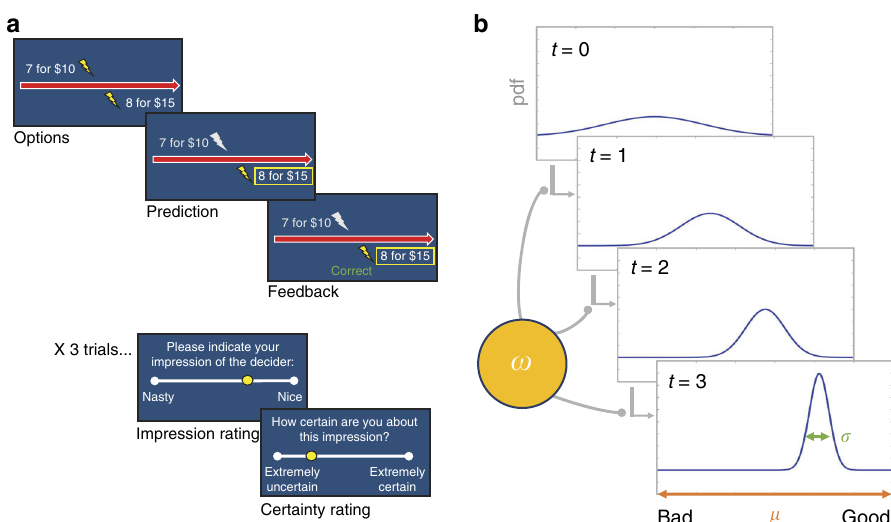
Fig. 1 Learning task and model. a Representation of the task schematic, created by the authors. Participants predicted sequences of choices for two agents (Decider A and Decider B). On each trial the agent chose between two options: more shocks in fl icted on another person in exchange for more money, or fewer shocks for less money. After making their prediction, participants observed the agent ’ s actual choice along with feedback indicating whether they were correct or not in their prediction. Every third trial participants made a judgment about the agent ’ s moral character (ranging from nasty to nice) and indicated how certain they were about their judgment. b Model schematic for learning about a good agent, modi fi ed from Siegel et al. 18 . Beliefs about the agent ’ s harm preference are represented by probability distributions with a mean μ and variance σ . Beliefs evolve over time as a function of Gaussian random walks whose step-size is governed by ω , a participant-speci fi c parameter that captures individual differences in the rate at which beliefs evolve over time, t